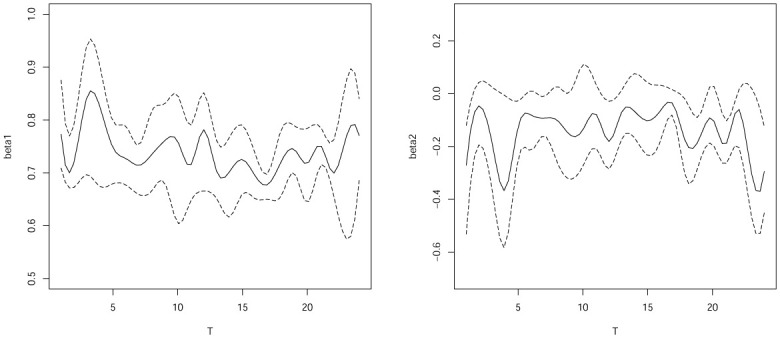
Estimates and the corresponding pointwise confidence interval of β1(t), β2(t) for interval censored data.